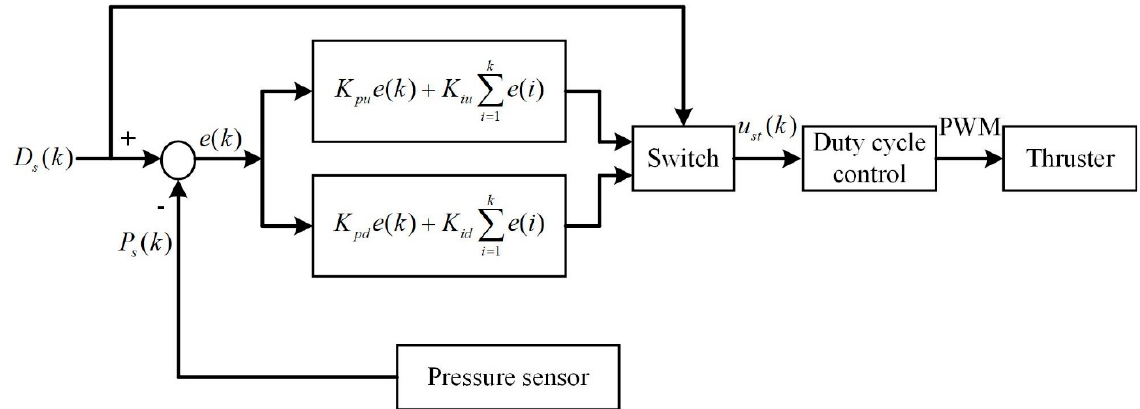
Figure 9. System control flow chart.